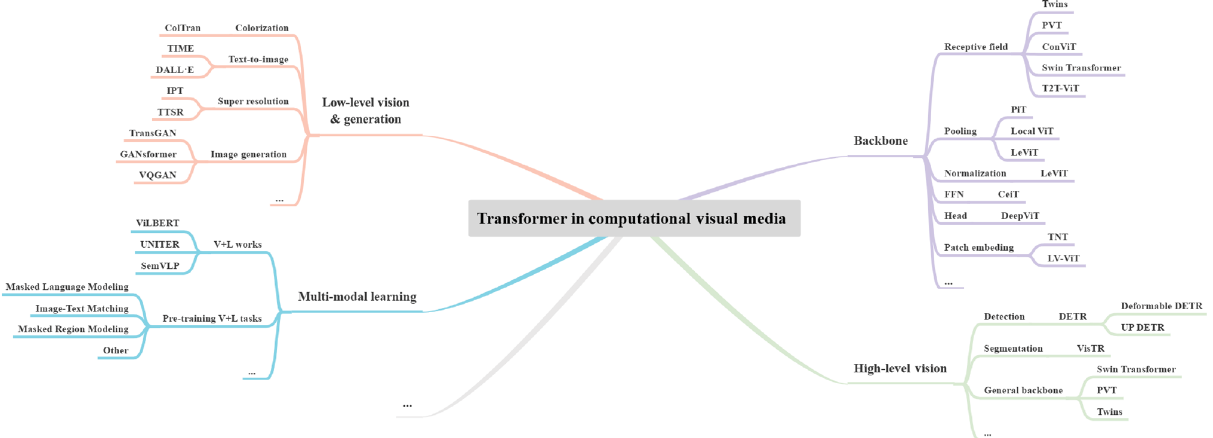
Fig. 1 Organisation of recent works on visual transformers.